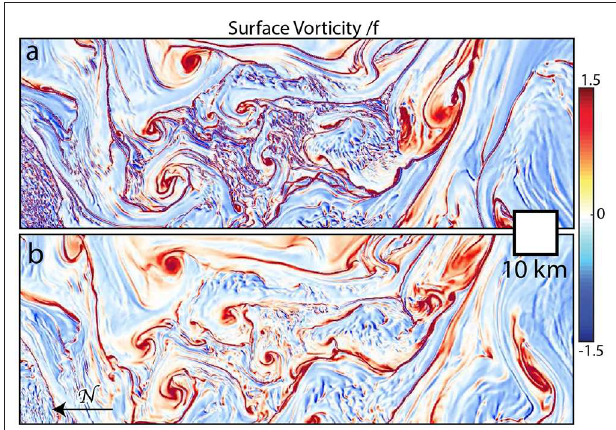
FIGURE 7 | Simulated surface vertical vorticity divided by the Coriolis frequency from a model of the DeSoto Canyon region of the northern Gulf of Mexico (Barkan et al., 2017a) with a horizontal resolution of 150 m forced by realistic air-sea fluxes and river input, and nested within a lower resolution model of the North Atlantic. (a) Vorticity near time of maximum variance. (b) Same but near time of minimum variance a few hours